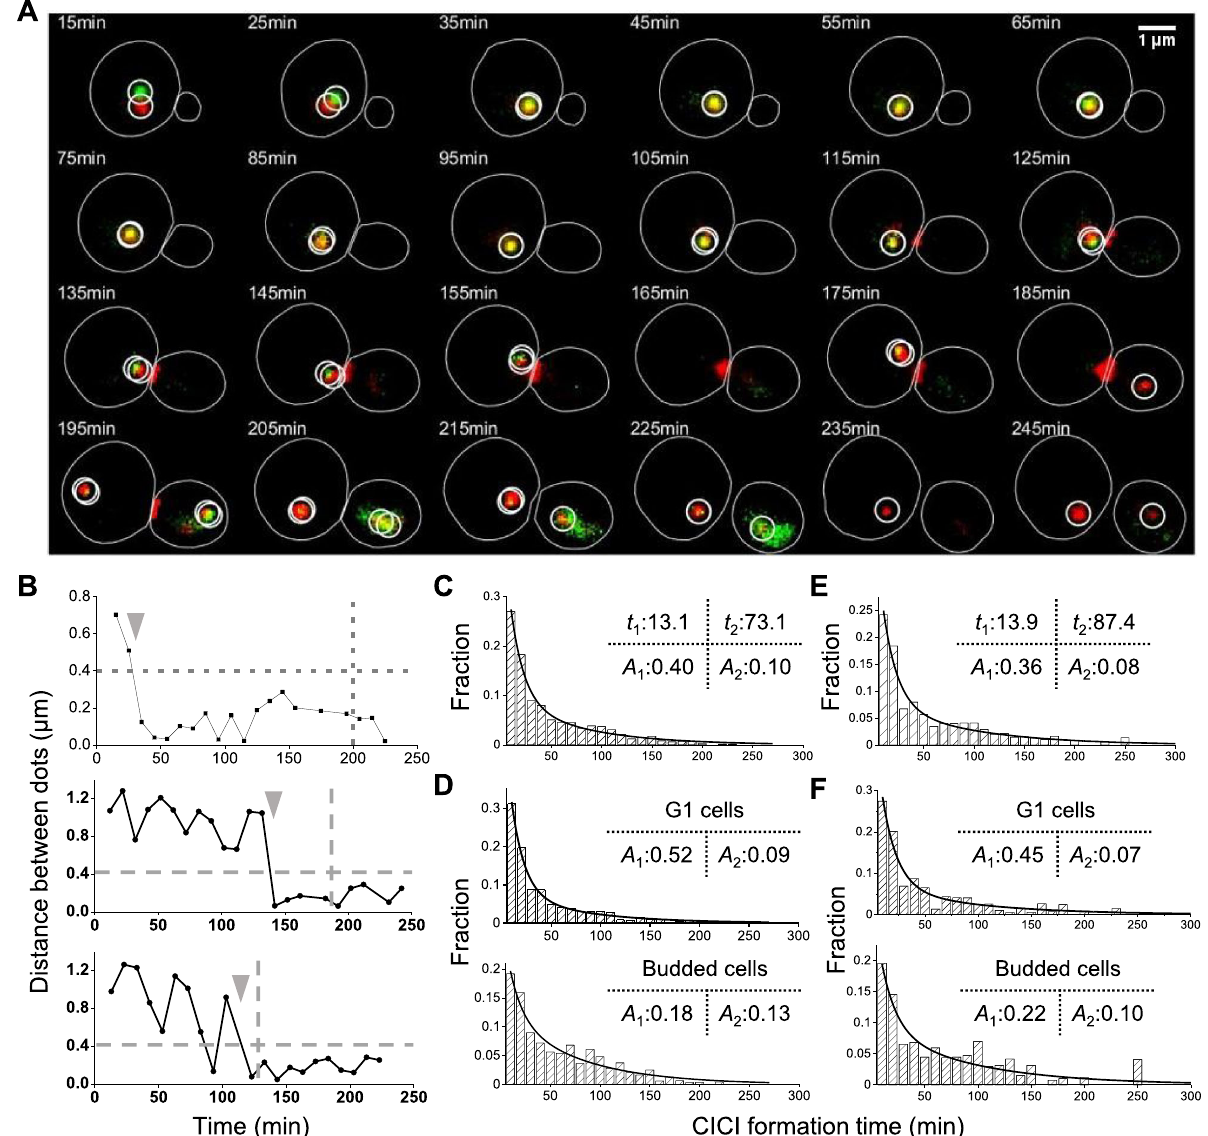
Fig. 3 CICI formation in real time. A Example time-lapse images of CICI strain (pair 5). The chromatin dots at the LacO and TetO arrays are circled. The budneck is labeled with Myo1-mCherry. B Distance between LacO and TetO arrays as a function of time in three cells. The upper panel is derived from the mother cell in ( A ). The horizontal line represents the co-localization threshold (0.4 µ m), and the vertical lines show the time of cell division. The gray arrows point to the CICI formation time in these three single cells. C Histogram of CICI formation time for all cells (LacO and TetO pair 5, N = 773). The histogram is fi tted with double exponential curves, and the time constants and amplitudes of the two phases ( t 1 , t 2 , A 1 , and A 2 ) are shown. D Histogram of CICI formation time for cells divided into two different cell cycle stages ( N = 480 and 255 for G1 and budded cells, respectively). The double exponential fi t has the same t 1 and t 2 , but different A 1 and A 2 . E , F Same as C and D , except that LacO and TetO arrays are placed on the two sides of the nucleolus (pair 4). N = 378, 220, 135 for all cells, G1 cells and budded cells, respectively. Source data for B – F are provided as a Source Data fi